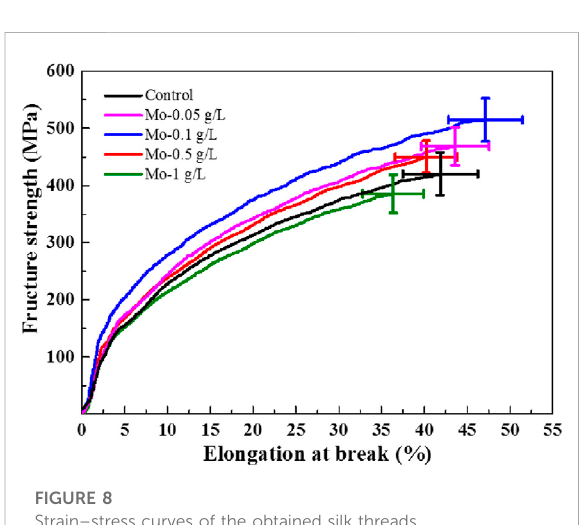
Strain – stress curves of the obtained silk threads.